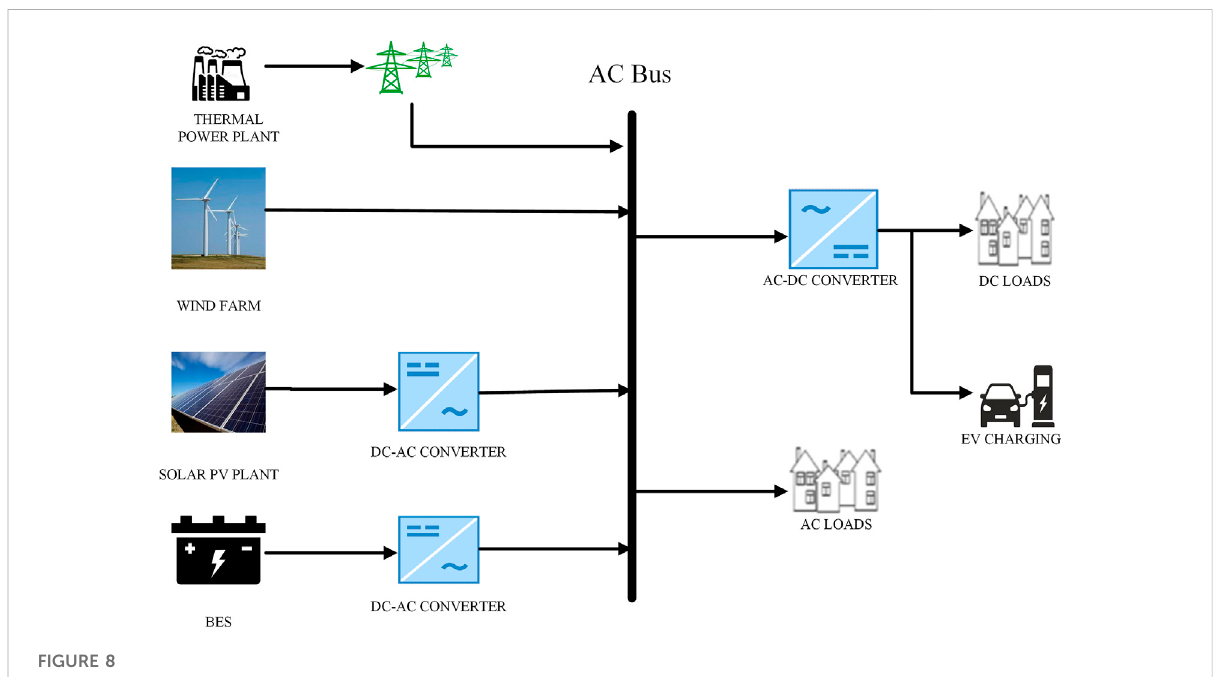
FIGURE 8 Microgrid